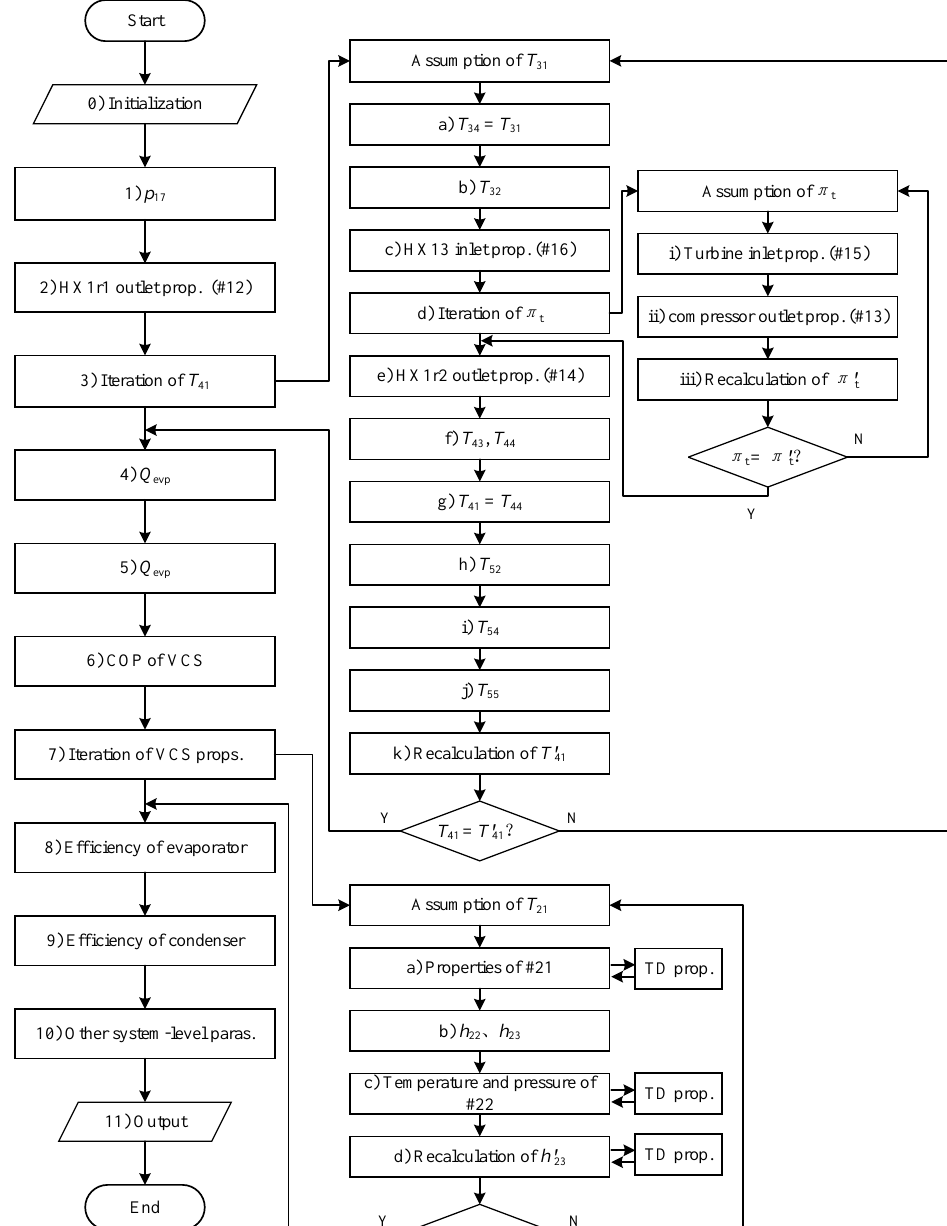
Figure 4. Flow chart of parameter matching of integrated thermal management